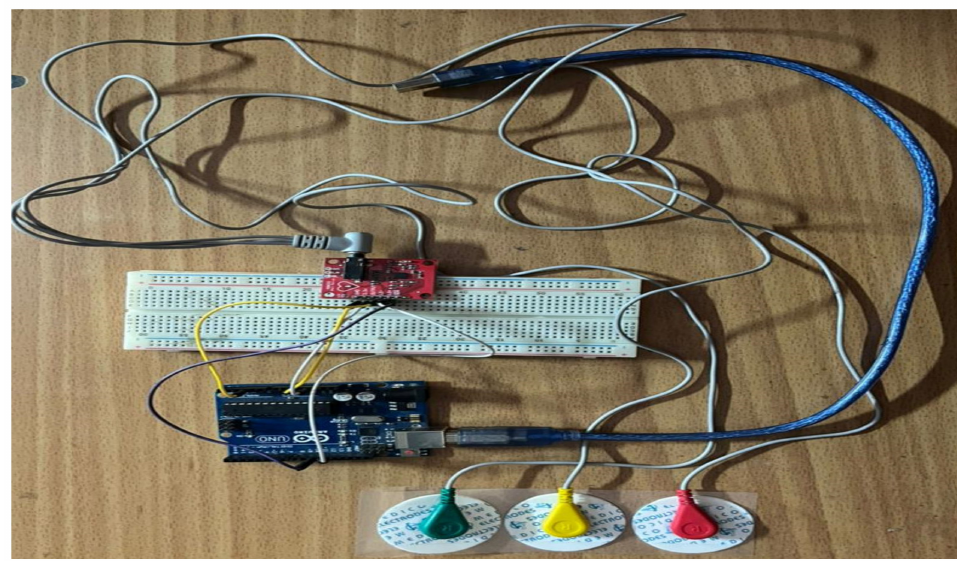
Figure 3. Overview of our real-time smart wearable ECG acquisition setup.